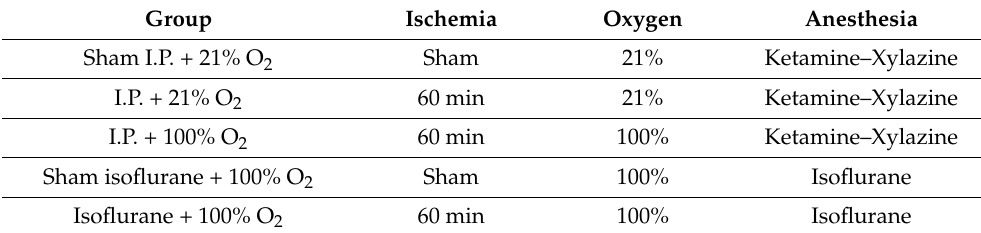
Table 1. Experimental